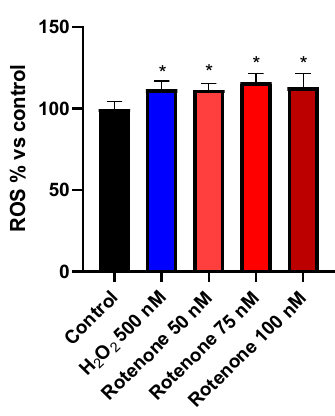
Figure 2. Histograms illustrating ROS production in BV-2 cells treated with increasing concentrations of rotenone (50–100 nM). Each column represents the average ± SEM of the percentage of the fluorescence, normalized with respect to the control, resulting from data of 3 independent experiments ( n = 6). * p < 0.05 vs control, one-way ANOVA followed by Bonferroni post hoc test.